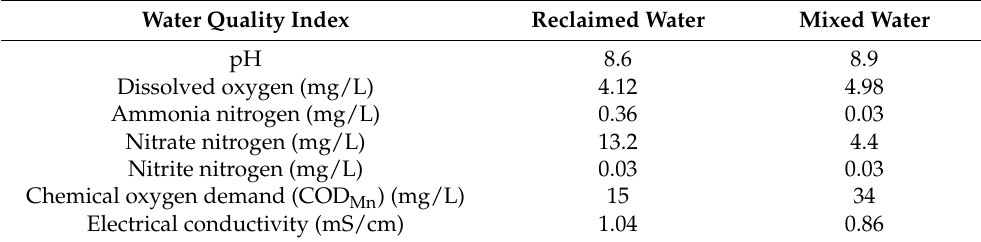
Table 2. Initial water quality of the two water